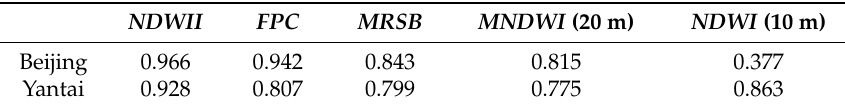
Figure 11. Manual drawing of typical water bodies in the study areas ( left : Beijing; right : Yantai. The image is true color synthesis with band 4, 3, & 2) to assess the boundary index. Table 3. The boundary index utilizing different water indices.